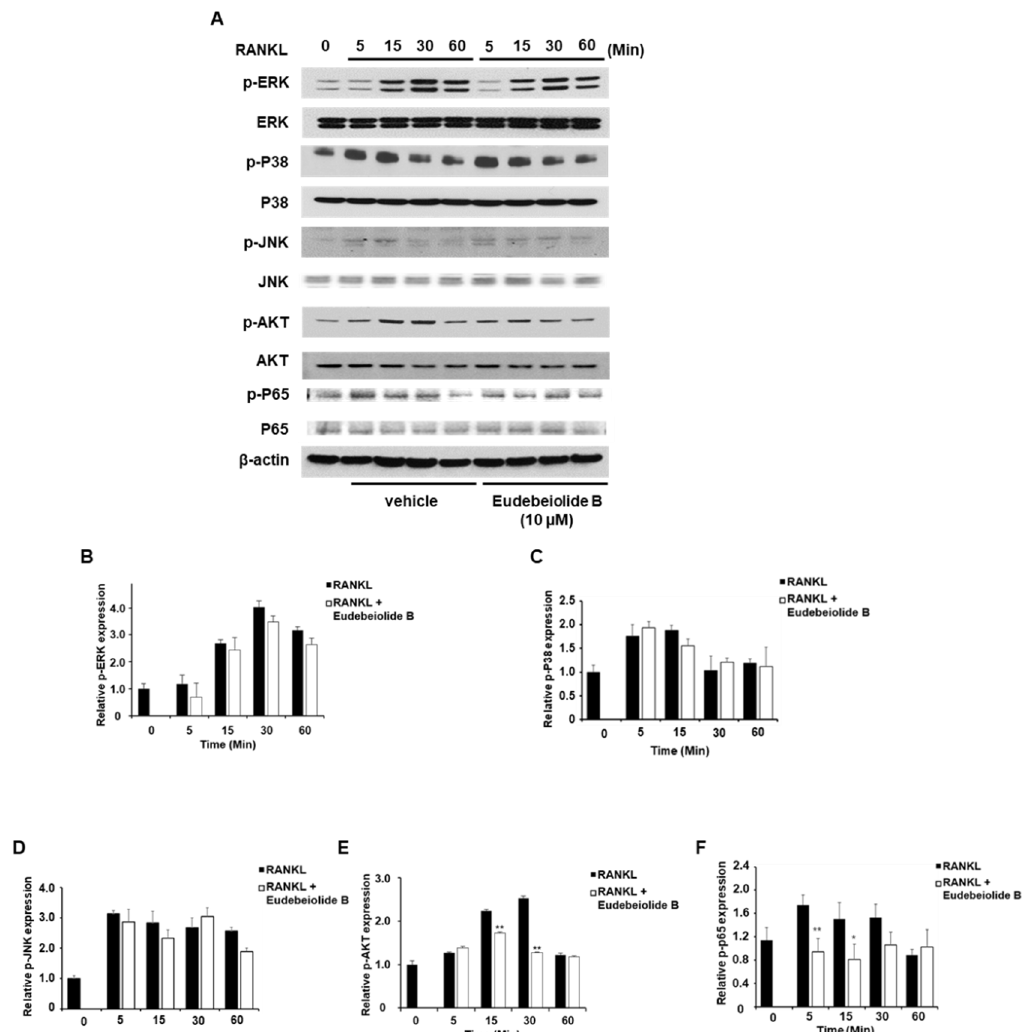
Figure 3. Effect of eudebeiolide B on RANKL-induced cellular signaling. BMM cells were pretreated with or without eudebeiolide B (10 μM) for 1 h and then stimulated with RANKL (100 ng/mL) for the indicated times. ( A ) Expression of signaling molecules determined by Western blot analysis. Band optical densities of ( B ) ERK, ( C ) P38, ( D ) JNK, I AKT and ( F ) NF-κB p65 were evaluated by ImageJ software ( n = 3). All data are expressed as the means ± S.D. * p < 0.05 and ** p < 0.01 versus the only-RANKL-treated group obtained through the unpaired Student’s t -test.